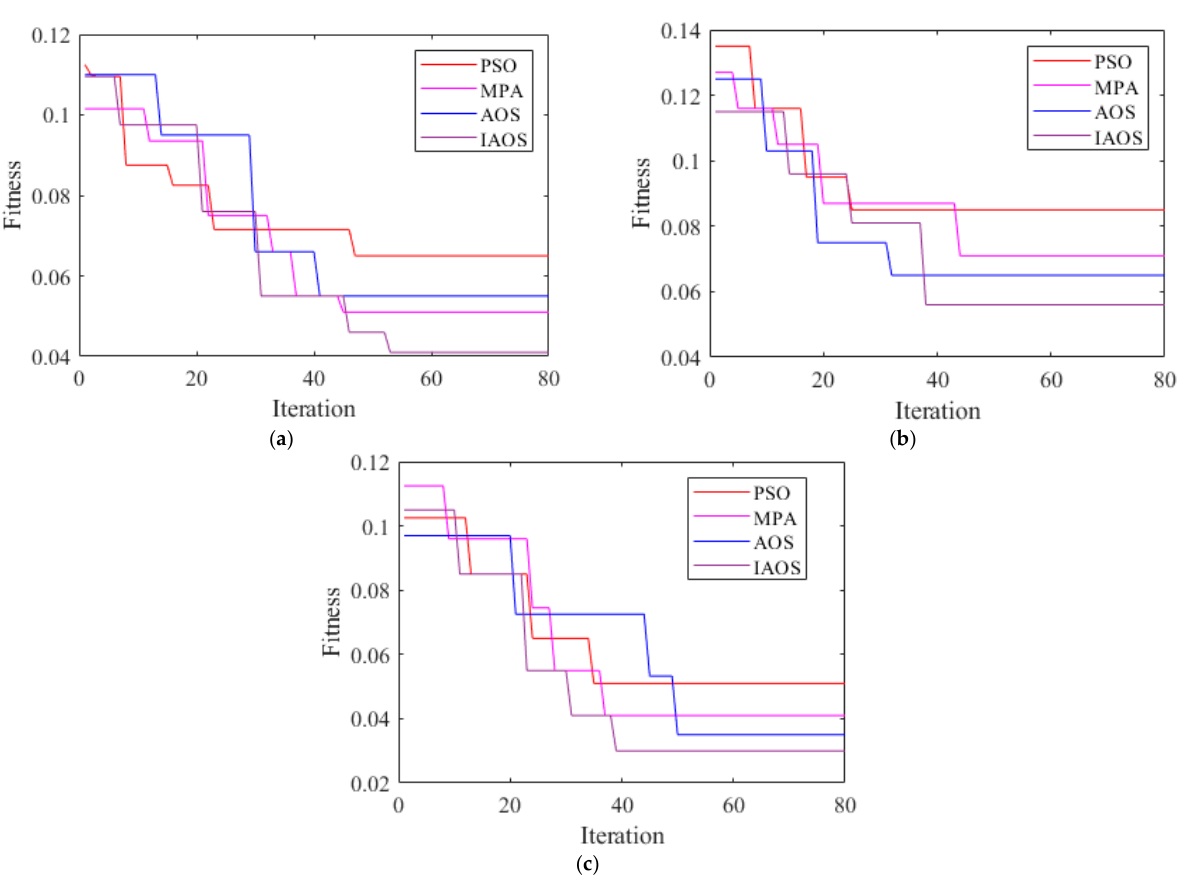
Figure 11. Convergence curve between PSO, MPA, AOS, and IAOS when using the optimal ILSTM- model: ( a ) w 1 ; ( b ) w 2 ; ( c ) w 3 .